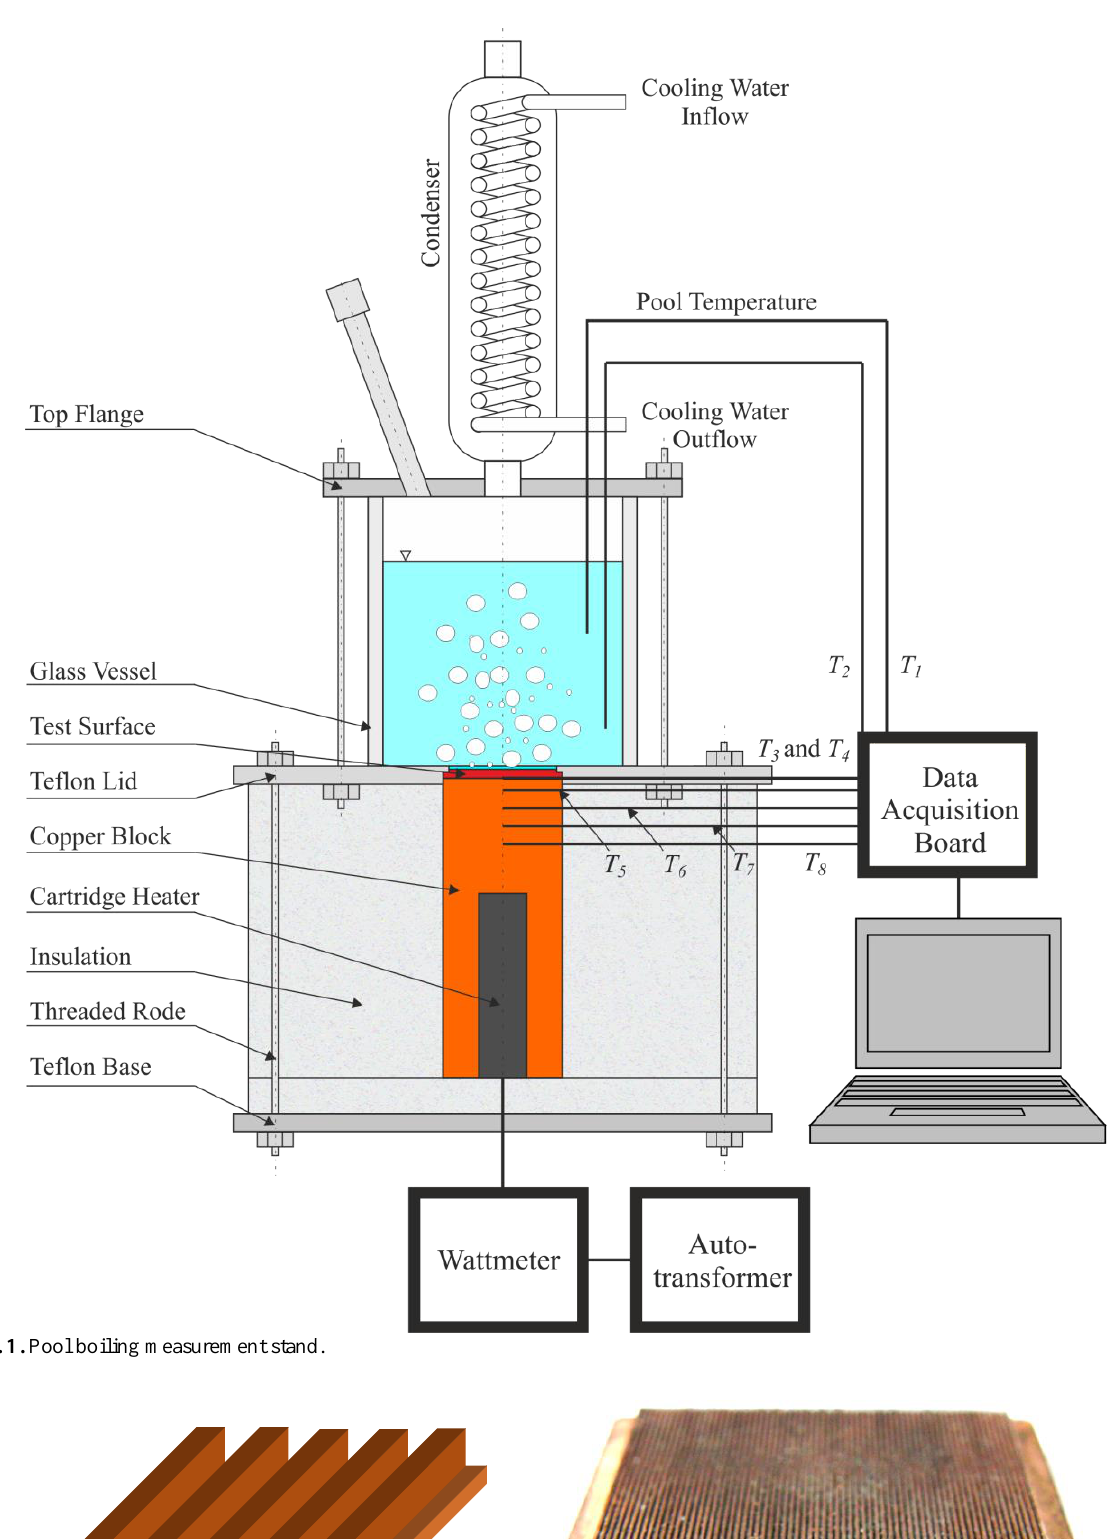
Fig. 2. Specimen with microchannels : a) dimension, b)